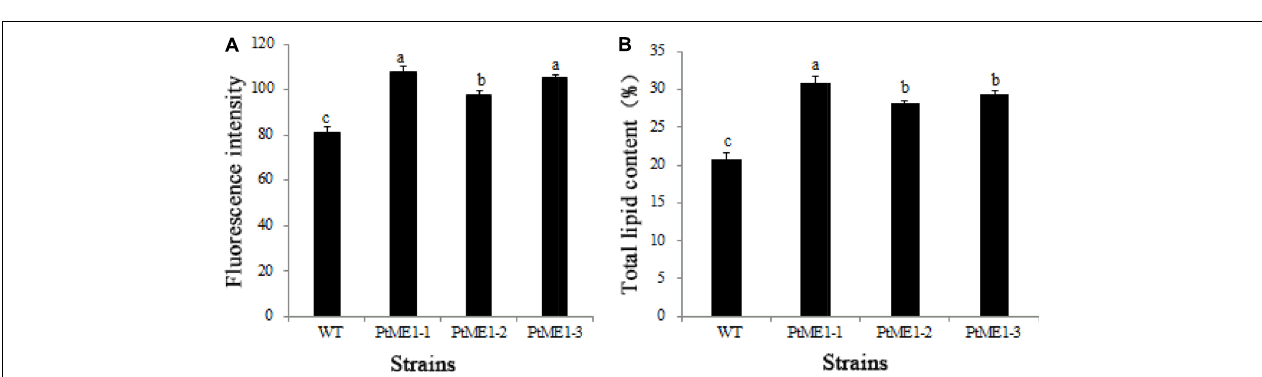
FIGURE 4 | Neutral-lipid accumulation and total lipid contents. (A) Neutral-lipid and (B) total lipid contents in the WT strain and the three Phaeodactylum tricornutum transformants. Values represent averages of three replicates ( n = 3). Values with different letters (a,b,c) indicate a significant difference between them ( p < 0.05).